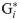
Spatial variation of social influence and its change over time, 1920–2012.a) Hot spot analysis of social influence for sample maps of US presidential elections (see S2–S25 Figs and S1 Movie for a complete analysis). The colored areas reflect the significance (p-value) of local concentration of social influence for each state. The p-values for each state are derived from a random permutation test of local clustering using the Getis-Ord Local Gi* statistic. This analysis was performed with a contiguity spatial weight matrix that indicates whether states share a boundary or not. The variable of concern is the social influence index calculated using Eq 7 in the main text. Low p-values (p-value≤0.1) indicate statistically significant high levels of social influence at a state and its surrounding neighbors (hot spots). High p-values (p-value≥0.9) indicate statistically significant low levels of social influence at a state and its surrounding neighbors (cold spots). b) Heatmap of the correlation coefficients between pairs of election years characterized by their state-level social influence profiles.